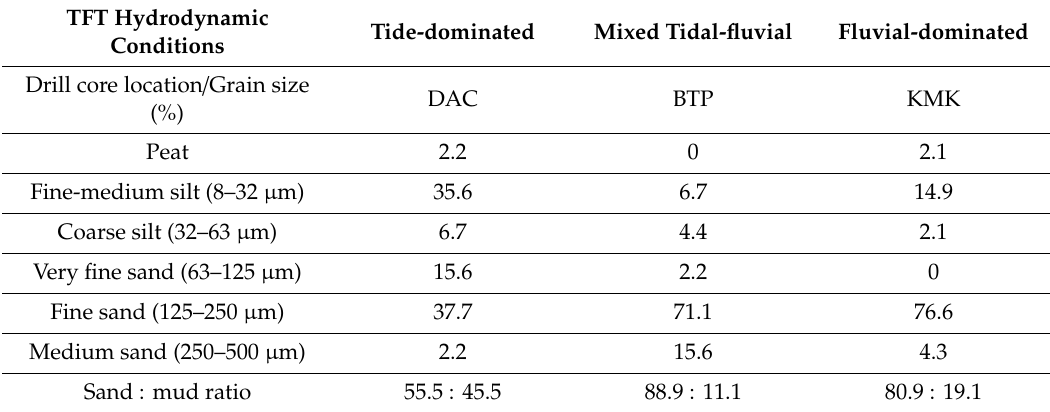
Table 2. Grain size proportions for drill core